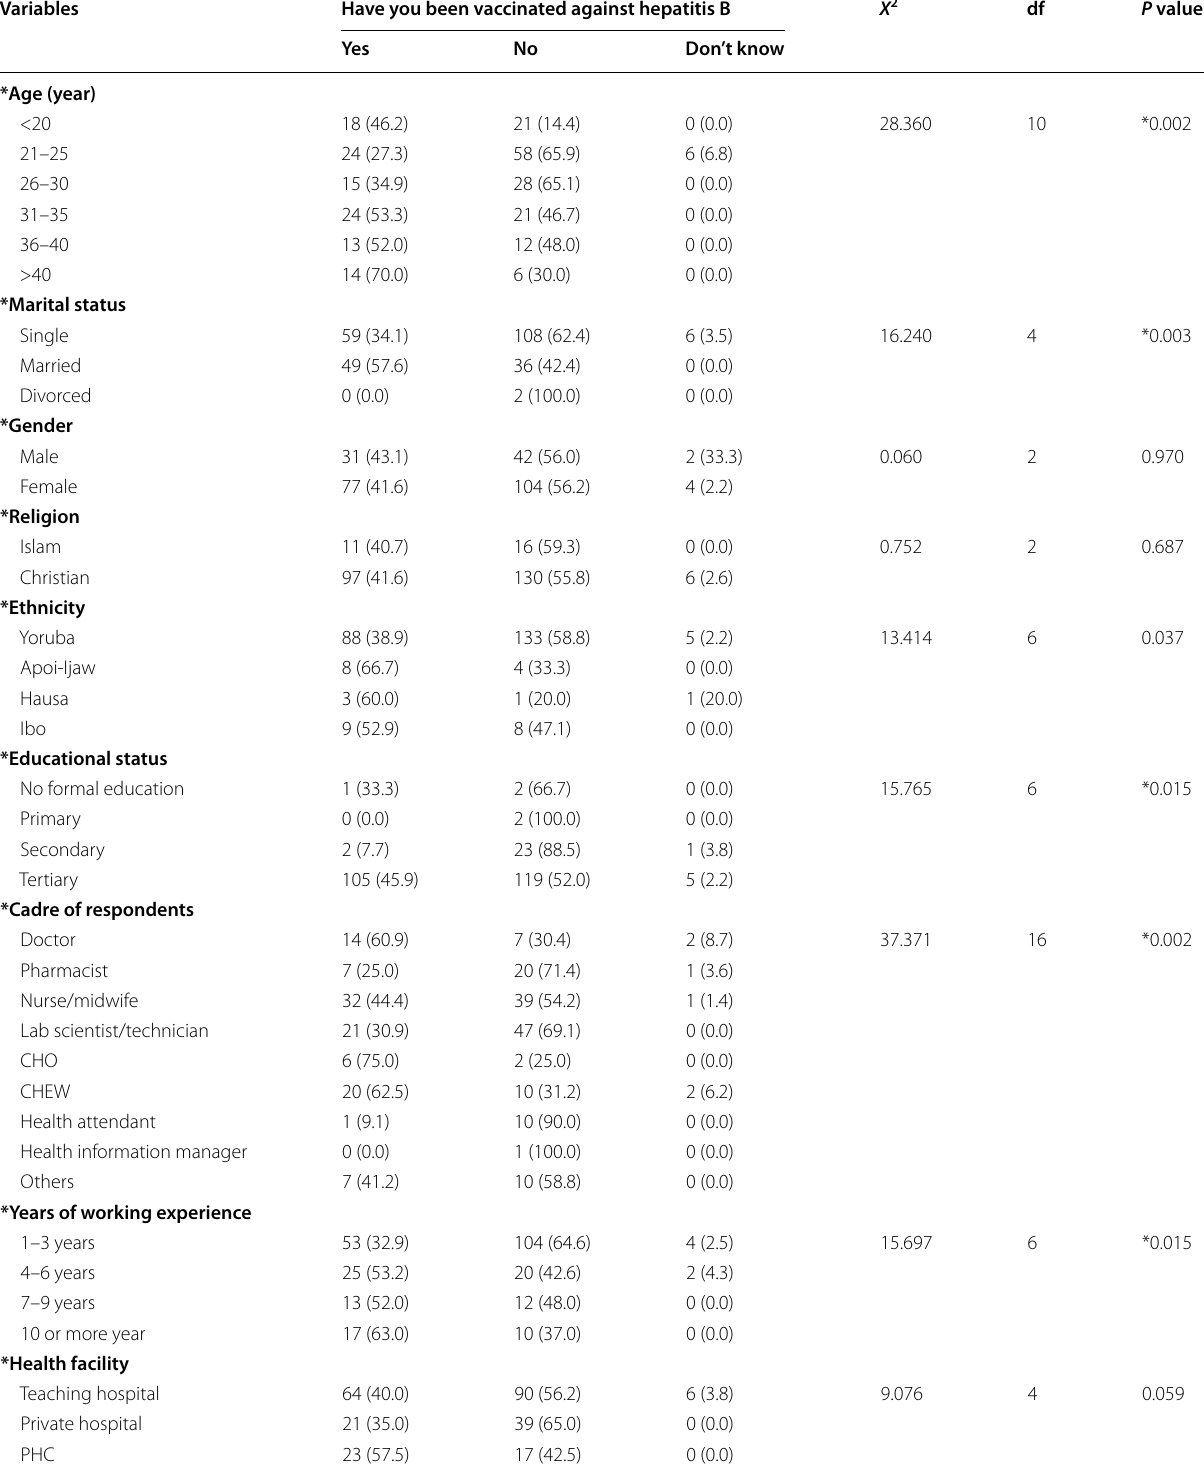
Table 5 Association between respondents’ socio-demographic characteristics and uptake of hepatitis B